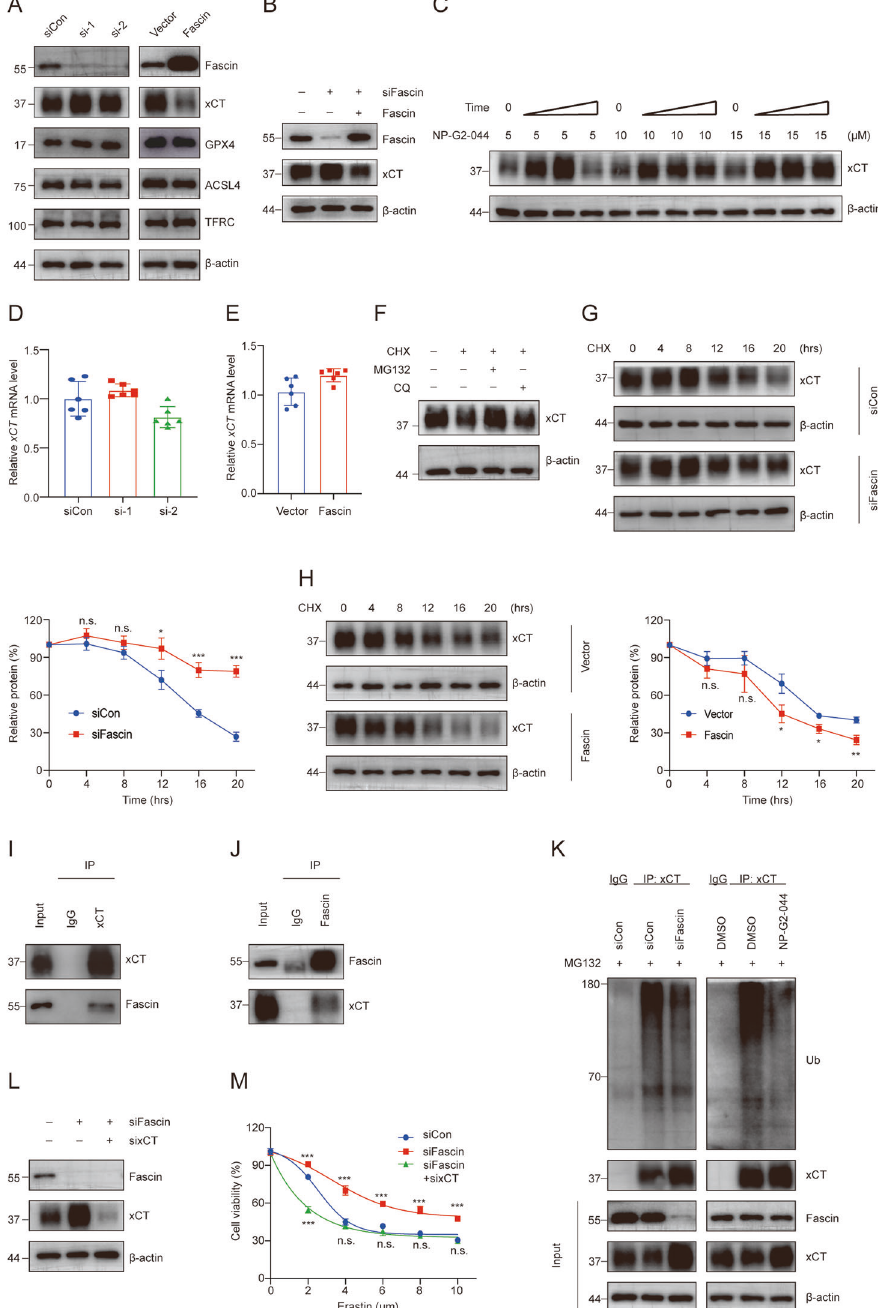
Fig. 5 Fascin interacts with xCT and decreases its stability. A Induction of ferroptosis-related proteins upon Fascin knockdown and overexpression in MDAMB231 cells. Cell lysates were collected after 72 h of transfection. B Western blot analysis showed that Fascin knockdown increased xCT levels, which was reversed by re-expression of Fascin. C Western blot analysis of xCT protein levels in MDAMB231 cells treated with NP-G2-044 (5, or 10, 15 μ M) for the indicated times (24, 48, or 72 h). xCT mRNA was detected in Fascin knockdown ( D ) or Fascin-overexpressing ( E ) cells by quantitative qRT-PCR analysis. F Western blot analysis of xCT levels in MDAMB231 cells treated with CHX (100 μ g/ml) with or without MG132 (10 μ M) and CQ (25 μ M) for 16 h. G , H Fascin knockdown or overexpression cells were treated with 100 μ g/ml CHX for the indicated times. Relative xCT protein levels were quanti fi ed with ImageJ. I , J MDAMB231 cell lysates were subjected to immunoprecipitation (IP) with antibodies towards Fascin or xCT or with control immunoglobulin G (IgG). Immunoblot assays were performed using Fascin and xCT antibodies. K Immunoprecipitation of cell lysates with Fascin knockdown or incubated with NP-G2-044 (5 μ M) cells was performed with xCT antibody, after which lysates were immunoblotted with antibodies against Ub, xCT, Fascin, and β -actin. L Immunoblot analysis of Fascin, xCT, and β -actin in MDAMB231 cells transfected with control or Fascin siRNAs with or without xCT siRNAs for 72 h. M MDAMB231 cells transfected with control or Fascin siRNAs with or without xCT siRNAs were incubated with the indicated concentrations of erastin for 48 h and then assayed for cell viability. n.s. not signi fi cant. * p < 0.05, ** p < 0.01, and *** p < 0.001. The data are displayed as the means ± s.d of three independent